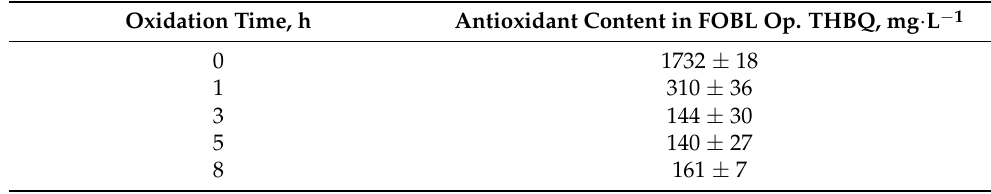
Table 6. TBHQ quantification during extreme oxidation of FOBL (Op.